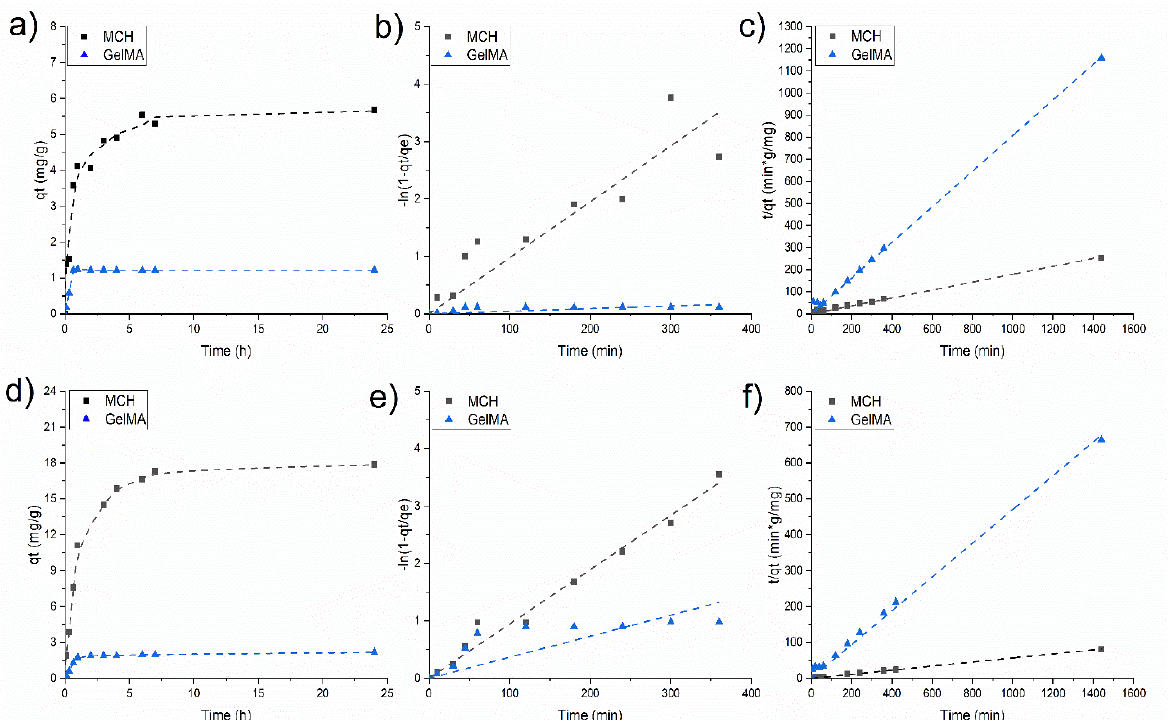
Figure 7. As(V) adsorption kinetics at ( a ) 10 mg/L and ( d ) 20 mg/L of initial concentration; ( b , e ) data fitted using the pseudo-first-order kinetic model with 10 mg/L and 20 mg/L of C 0 , respectively ( c , f ) data fitted using the pseudo-second-order kinetic model with 10 mg/L and 20 mg/L of C 0 , respectively. Table 2. Pseudo-second order fitting parameters for As(V)